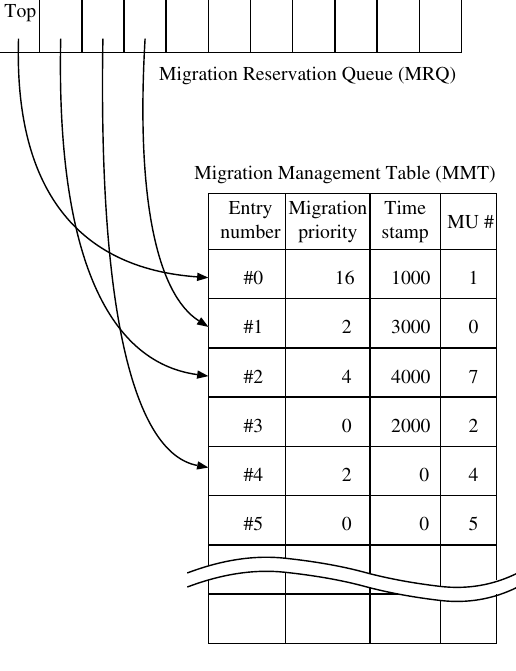
Fig. 3. An example of the migration reservation